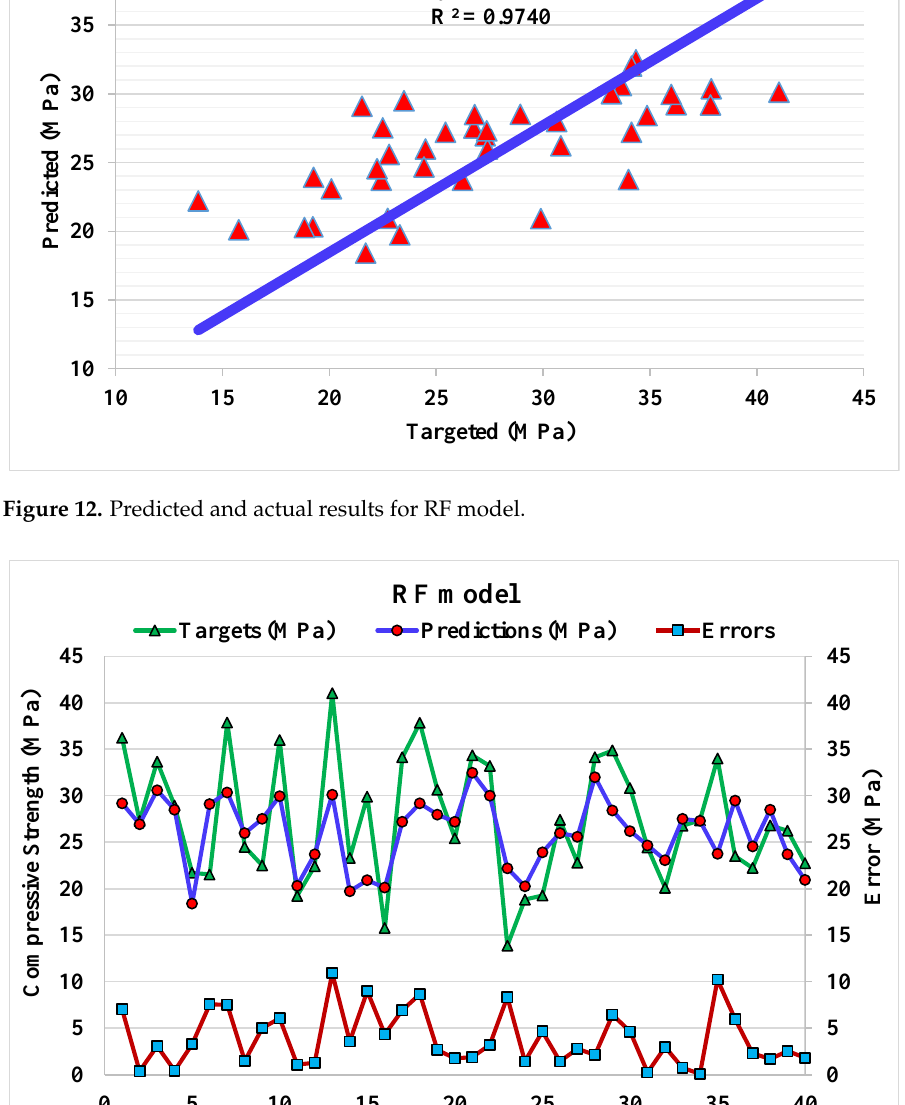
y = 0.956x R² = 0.9740